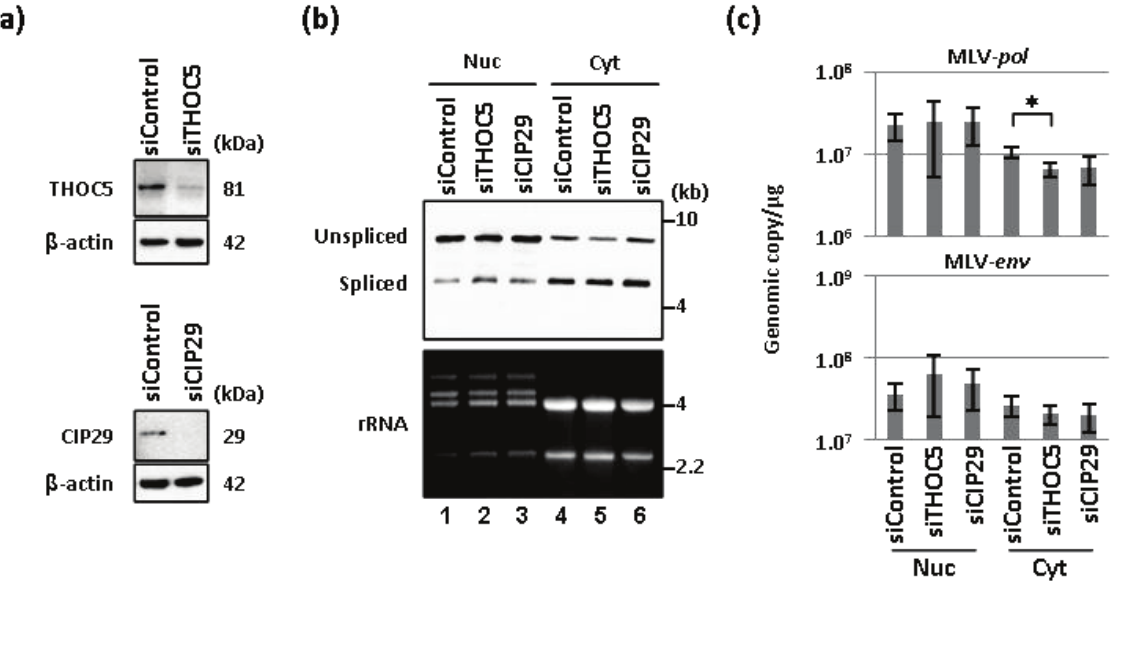
Figure 2. THOC5 and THOC7 are essential for MLV RNA export. ( a ) Western